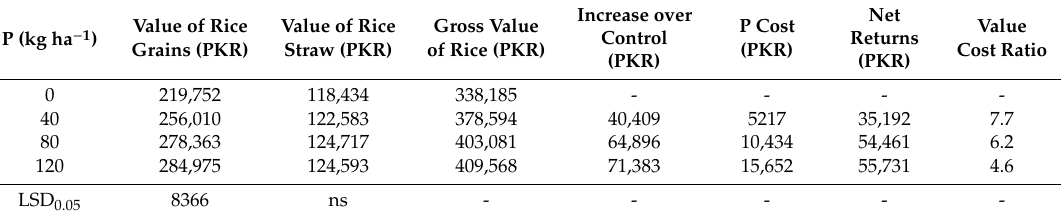
Table 2. Impact of phosphorus levels on the economic analysis (net returns and value cost ratio) of rice crop under rice-wheat cropping system.